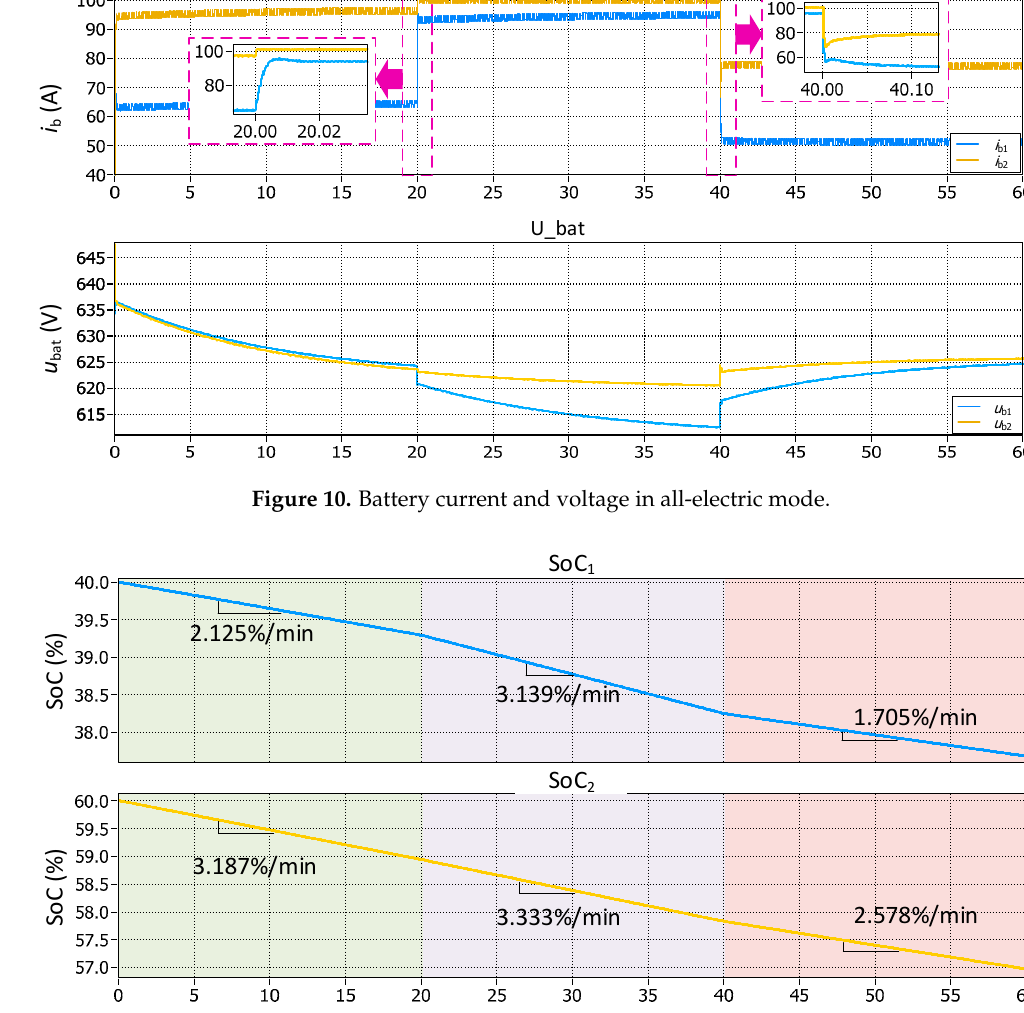
Figure 11. SoC of battery 1 and battery 2 in all-electric mode.